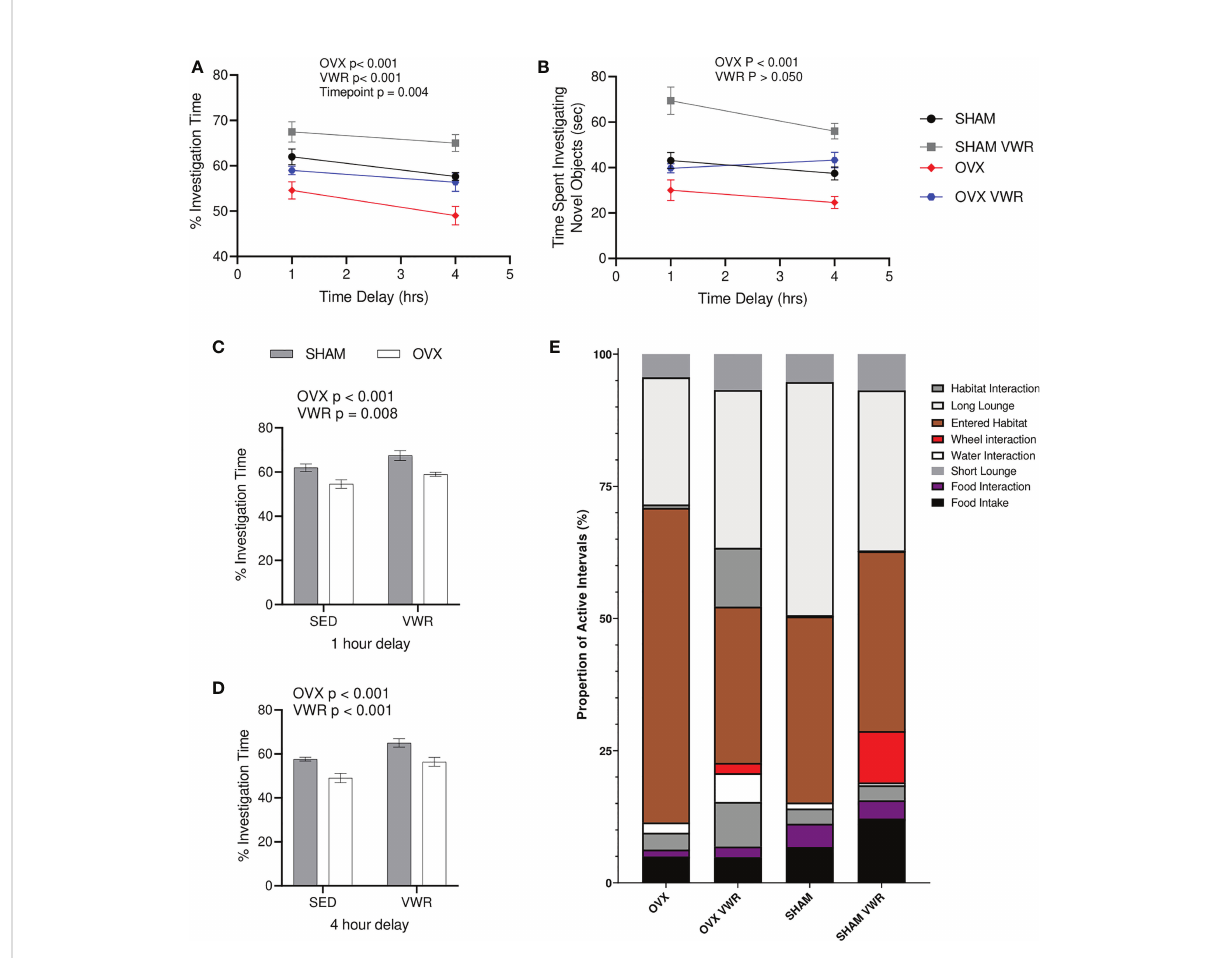
FIGURE 2 Novel Object Recognition Testing and behavioral characterization. (A) % investigation of novel object/total investigation time (%). (B) Total time spent investigating objects (s). (C) % investigation of novel object/total investigation time for 1-hour delay (%). (D) % investigation of novel object/ total investigation time for 4-hour delay (%). (E) 24-hour breakdown of behavioral characterization. All data analyzed using a two-way ANOVA besides (B). NORT, novel object recognition testing; SED, sedentary; VWR, voluntary wheel running; OVX, ovariectomized; SHAM, sham operated. Signi fi cance is set to P ≤ 0.05; n=10 per